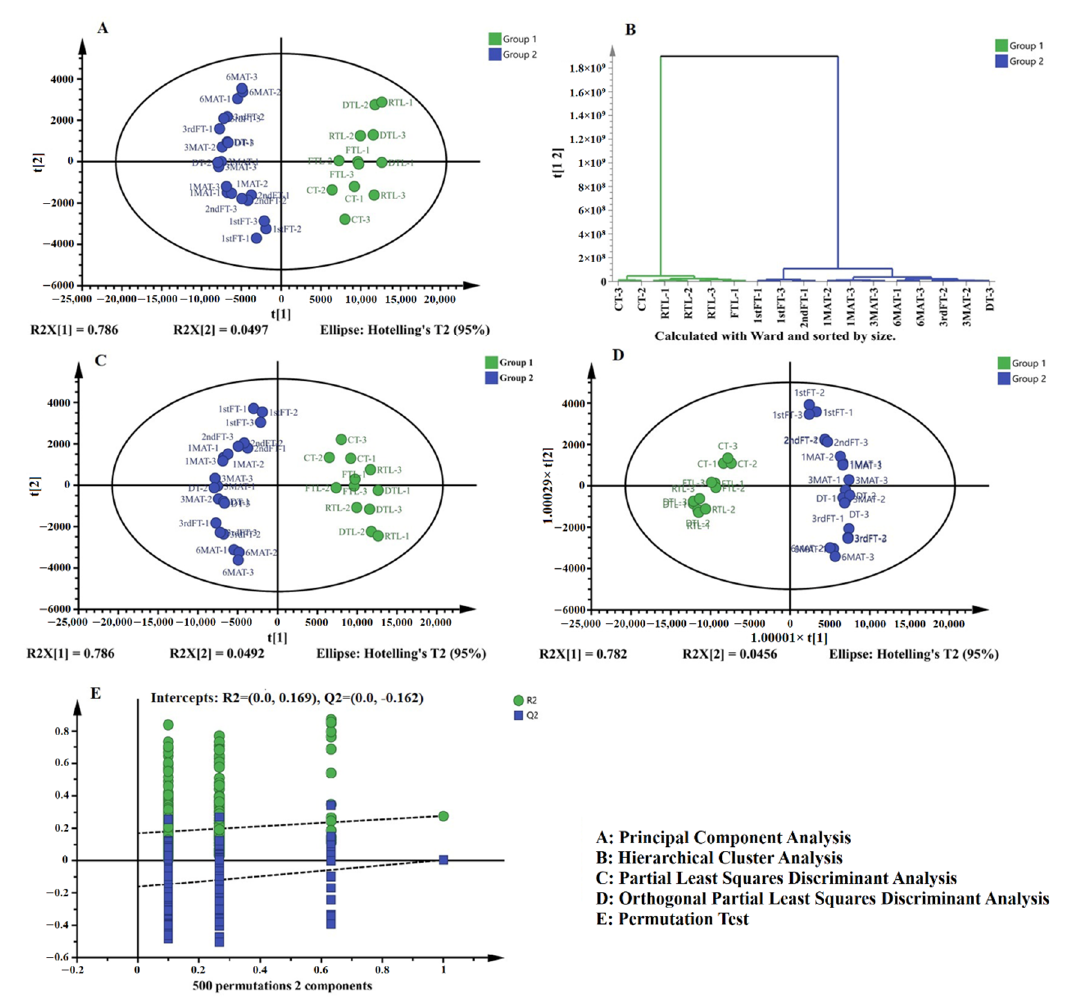
Figure 2. Multivariate analysis based on the LC-Q-TOF-MS data of QZT samples from different processing stages.